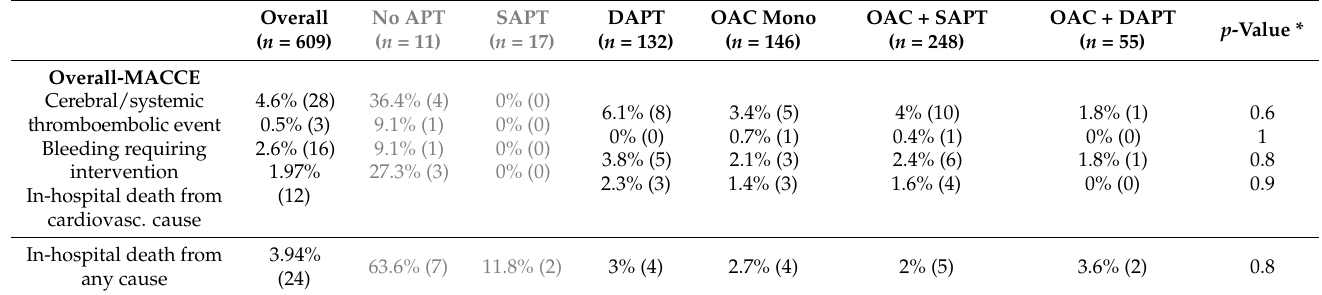
Table 2. Rate of major cardiovascular and cerebrovascular events (MACCE) and all-cause in-hos-